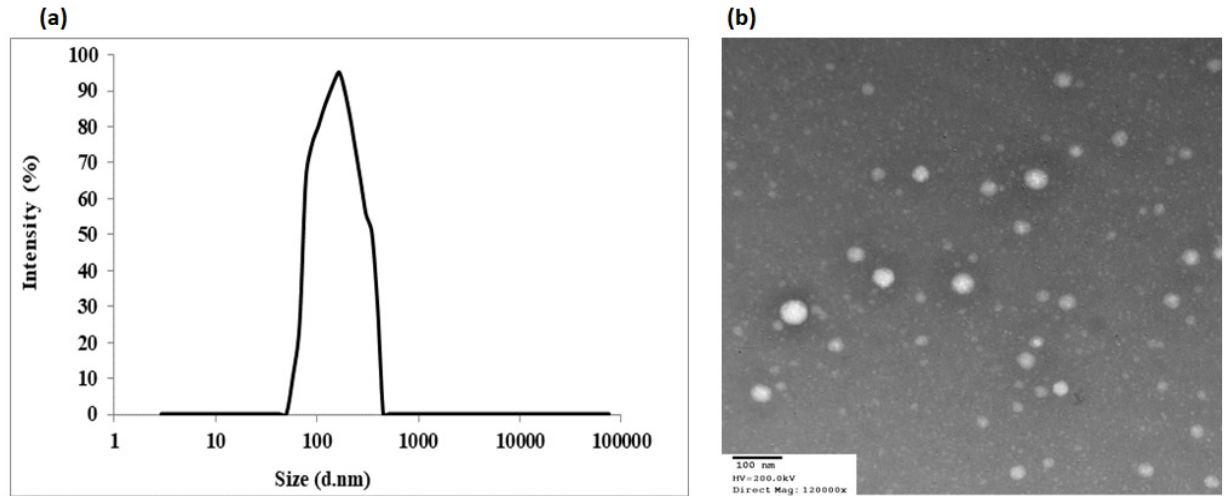
Figure 4. ( a ) Particle size distribution of QR-NE formula (F5). ( b ) QR-NEs (F5) Morphology under transmission electron microscopy (TEM) (magnification × 120,000).